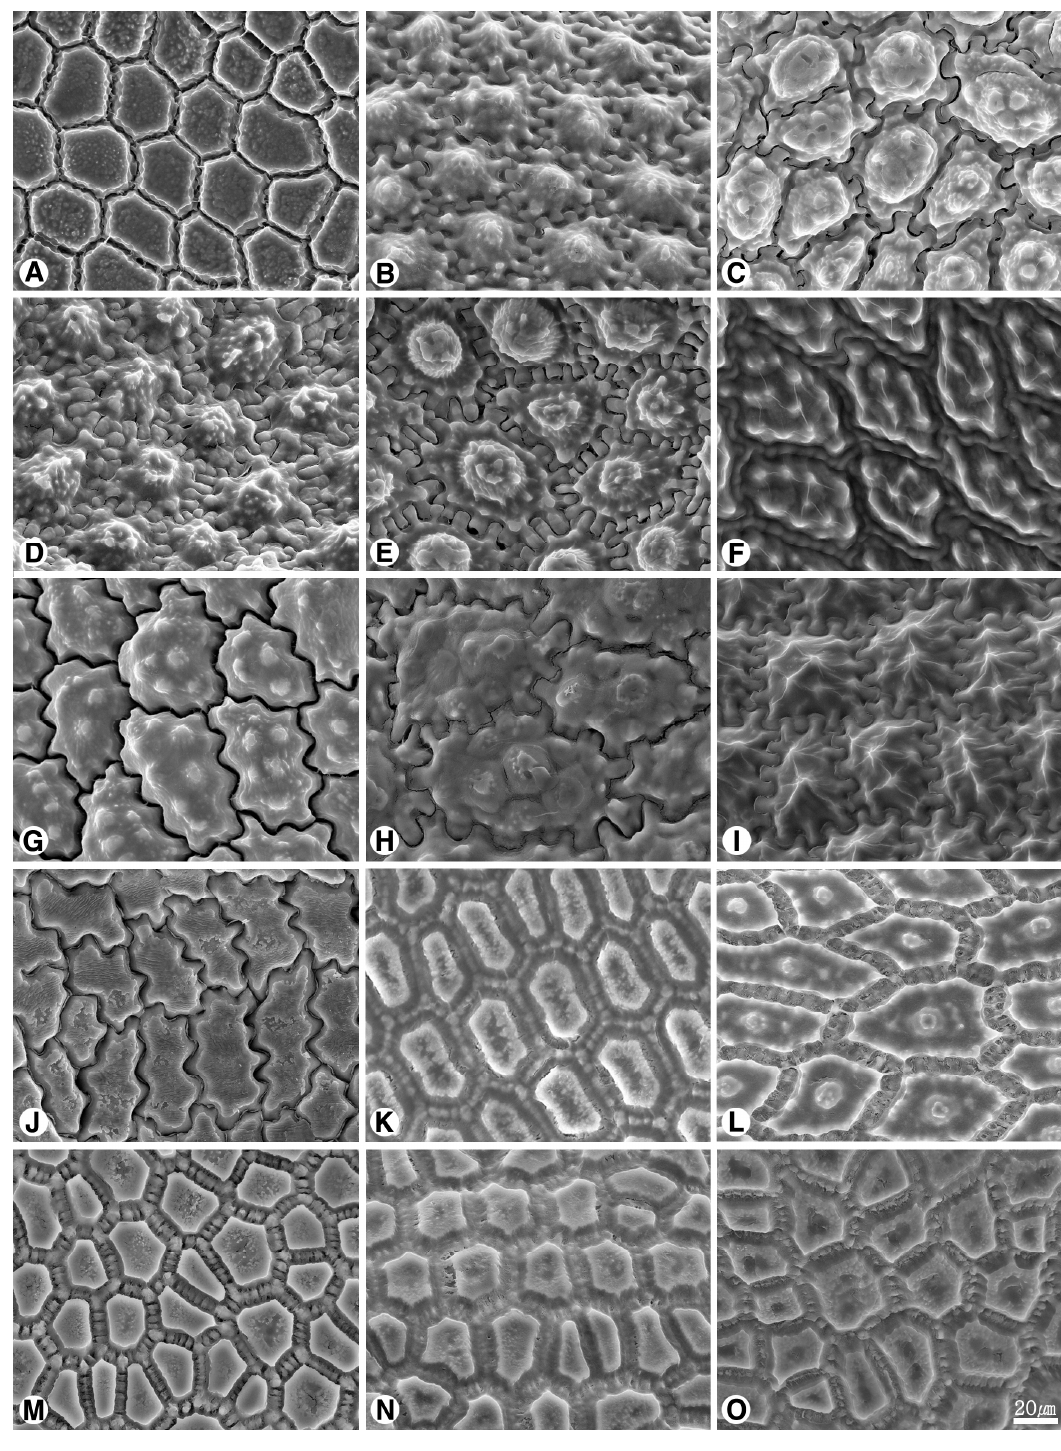
Figure 6. Scanning electron micrographs of seed testa in Allium . A A . maximowiczii , (sect. Figure6. Scanningelectronmicrographsofseedtestain Allium . ( A ) A . maximowiczii , (sect. Schoenoprasum